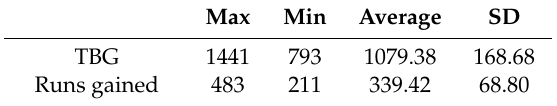
Table 1. Descriptive statistics of input-output indicators of CPBL teams’ o ff ensive performance.